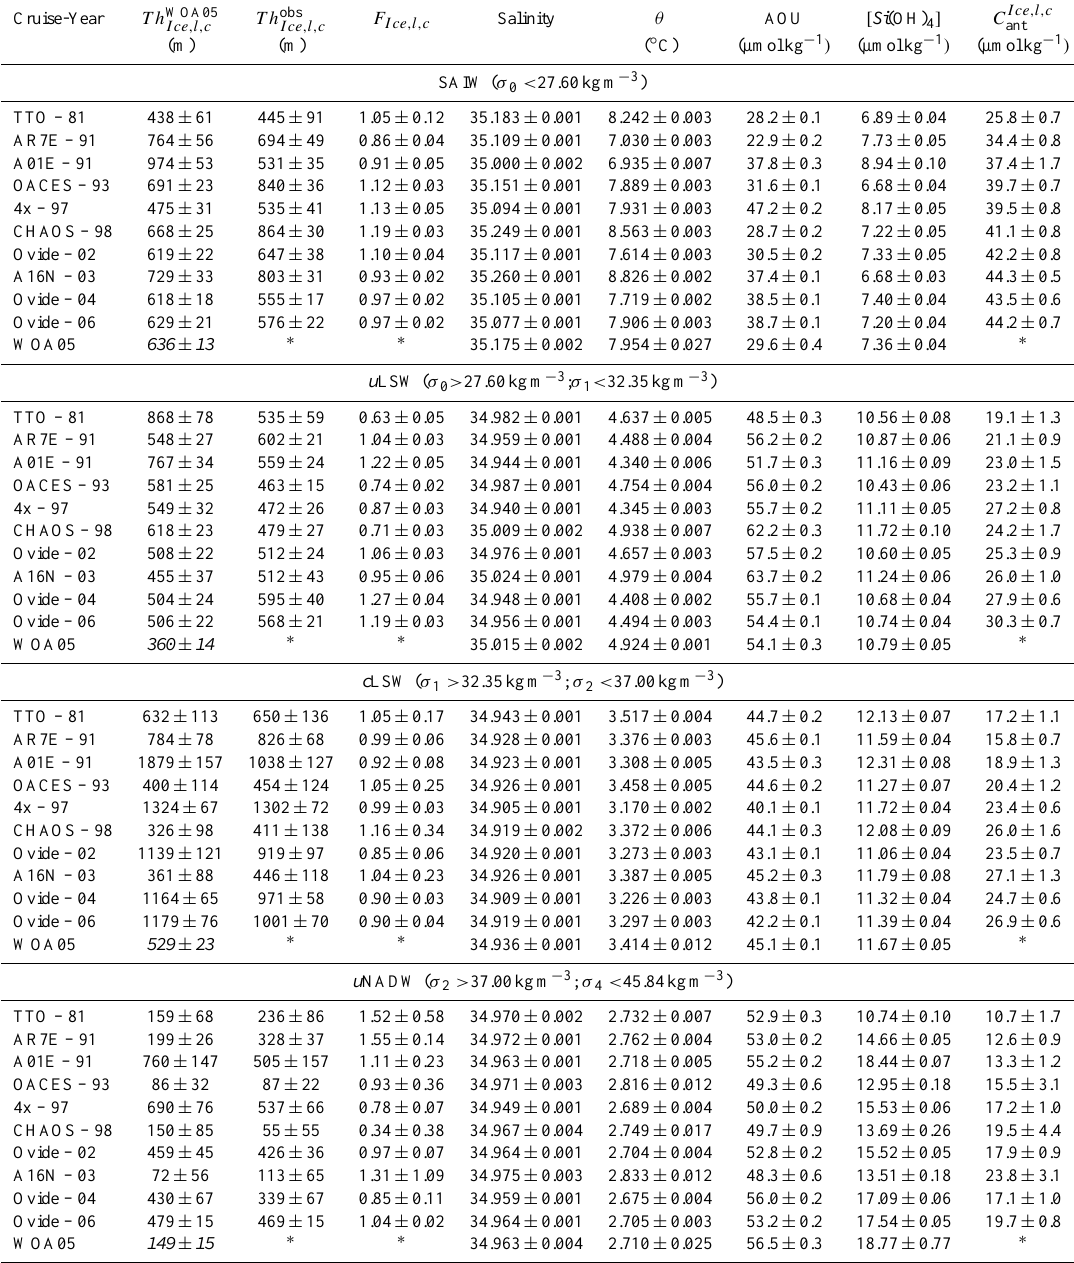
Table 2b. Iceland